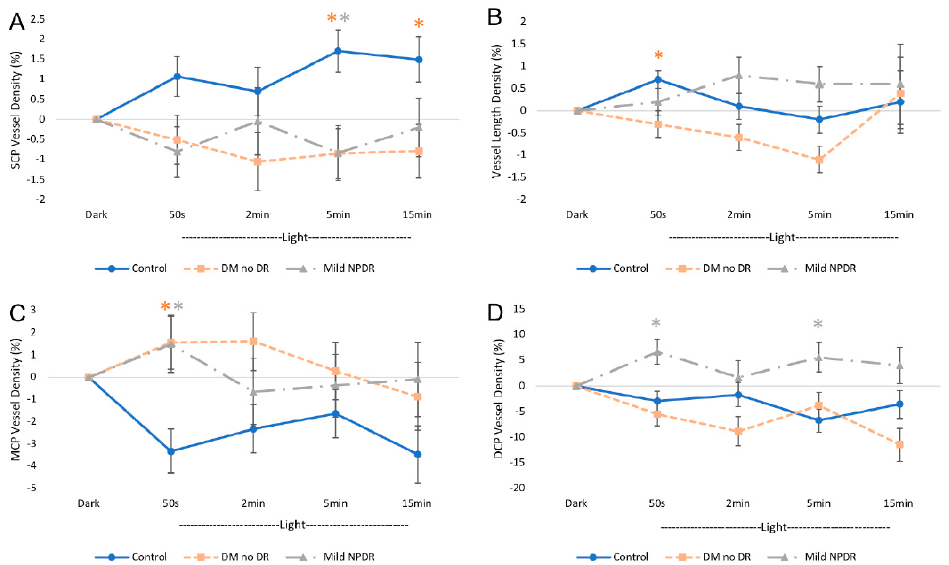
Figure 5. Parafoveal vessel density on OCTA during ambient light transition. Vessel density (VD) in ambient light at each timepoint in ( A – D ) are shown as values relative to the dark, which was set to zero. ( A,C – D ) show VD changes in the superficial (SCP), middle (MCP), and deep (DCP) vascular plexuses, respectively, at consecutive timepoints in ambient light after dark adaptation and comparing the control, DM no DR, and mild NPDR groups. ( A ) SCP VD is significantly increased at 5 min of ambient light in the control compared to the DM no DR and mild NPDR groups, which continues until 15 min in the control compared to the DM no DR group. ( B ) Vessel length density (VLD) measurements indicate significantly elevated VLD in the control compared to the DM no DR group at 50 s in ambient light. ( C ) In the middle capillary plexus (MCP), the two diabetic groups showed significantly increased VD at 50 s in ambient light compared to controls. ( D ) In the deep capillary plexus (DCP), the mild NPDR group showed significantly increased VD at 50 s and 5 min in ambient light compared to controls and to DM no DR. All timepoints with statistically significant differences ( p < 0.05) between the diabetic and control conditions are marked with an asterisk (*) and the color of the asterisk corresponds with the respective diabetic group that is different from the control. Error bars represent standard errors. Abbreviations: SCP—superficial capillary plexus, MCP—middle capillary plexus, DCP—deep capillary plexus, s—seconds, min—minutes.